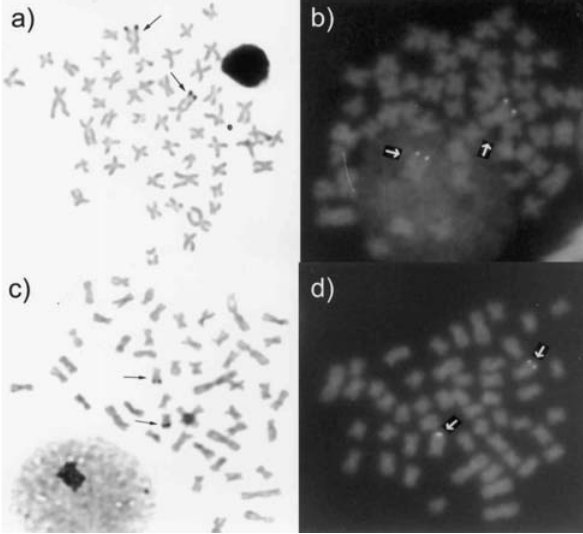
Figure 2 - Somatic metaphases of Characidium gomesi (a and b) and Characidium cf. zebra (c and d) from the Machado River, after silver ni- trate (a and c) and CMA 3 staining (b and d). The arrows point NOR- bearing